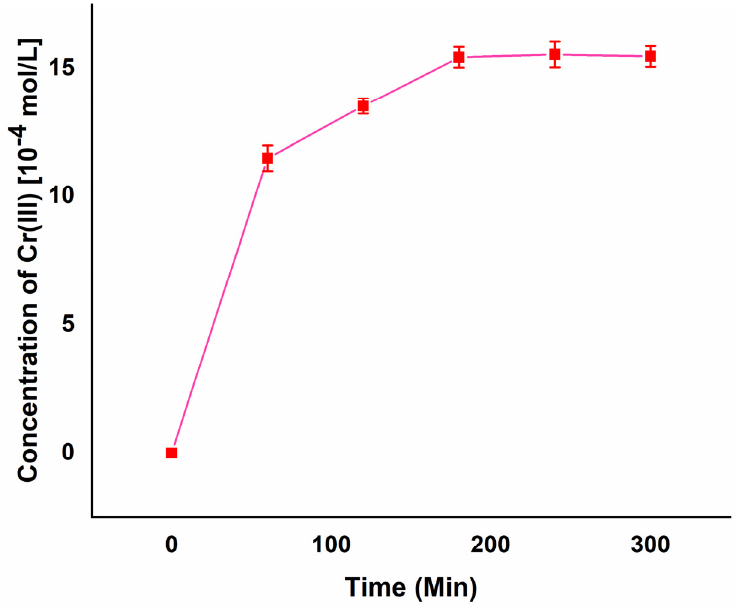
Figure 10. Extraction time.